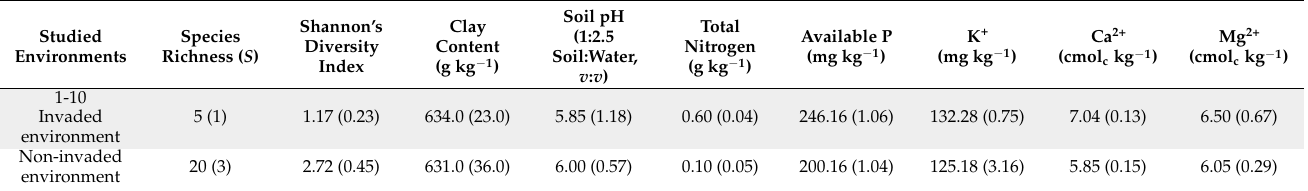
Table 1. Biodiversity indices of plant community composition and soil characterization (mean, N = 16) in both invaded and non-invaded environments in a tropical Cambisol, Caatinga ecoregion, Paraiba,